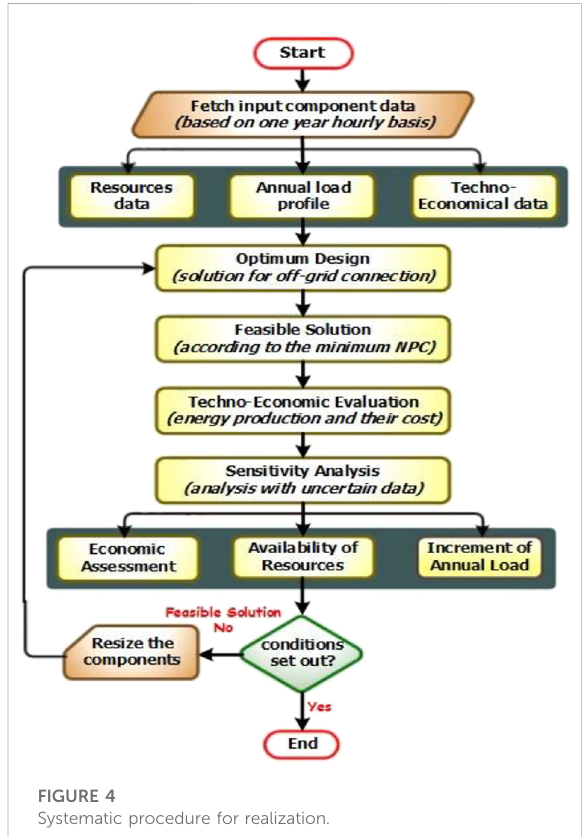
FIGURE 4 Systematic procedure for